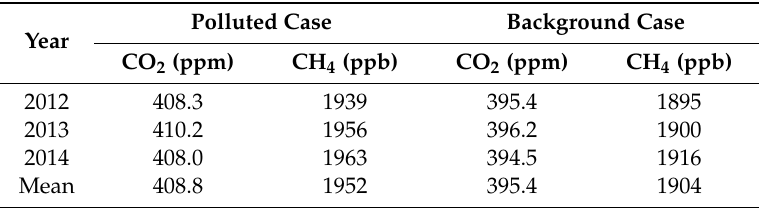
Figure A2. Time series of the measured ( a ) CO 2 and ( b ) CH 4 concentrations at the GS station from 2012 to 2014. The background and the polluted concentrations are illustrated in circled and squared symbols, respectively. Table A1. Summary of the filtered CO 2 and CH 4 concentrations observed for in GS for the 2012–2014